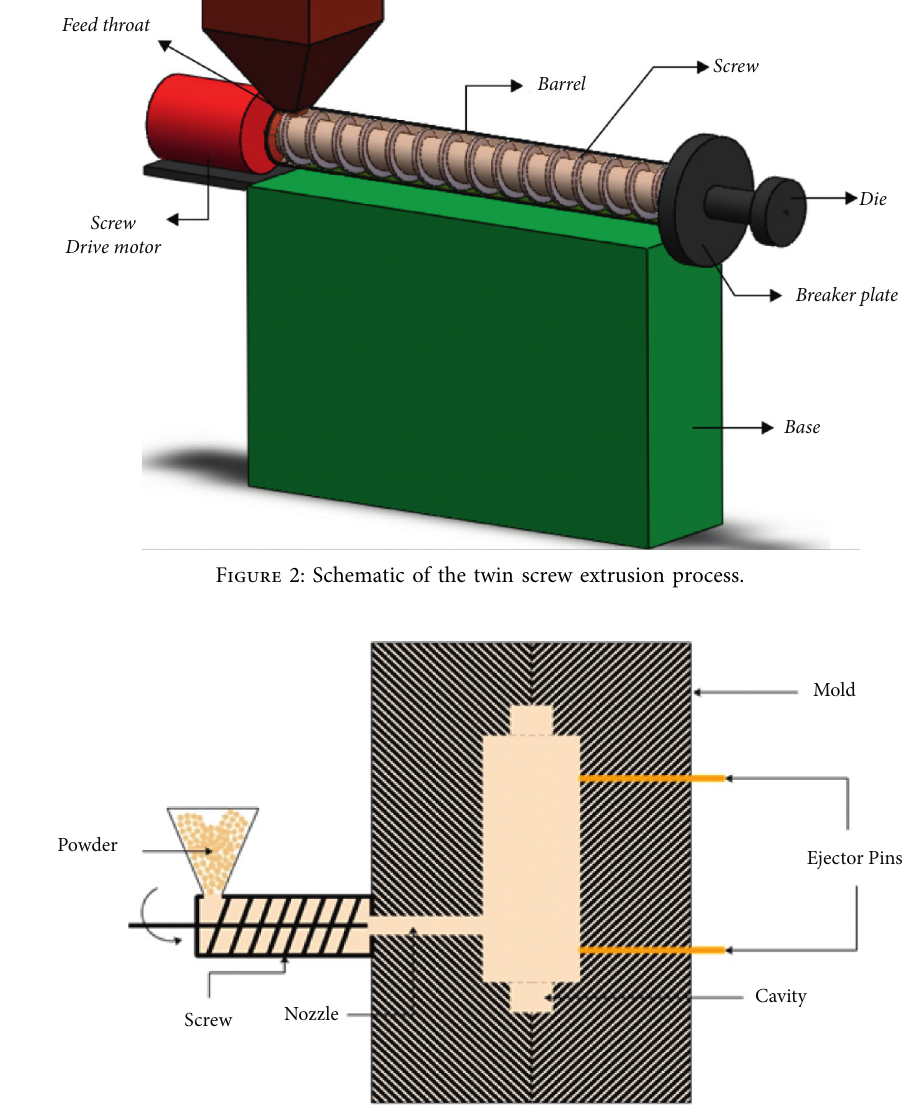
Figure 3: Schematic of the injection moulding process. Table 3: Detailed description of the composite specimens and its